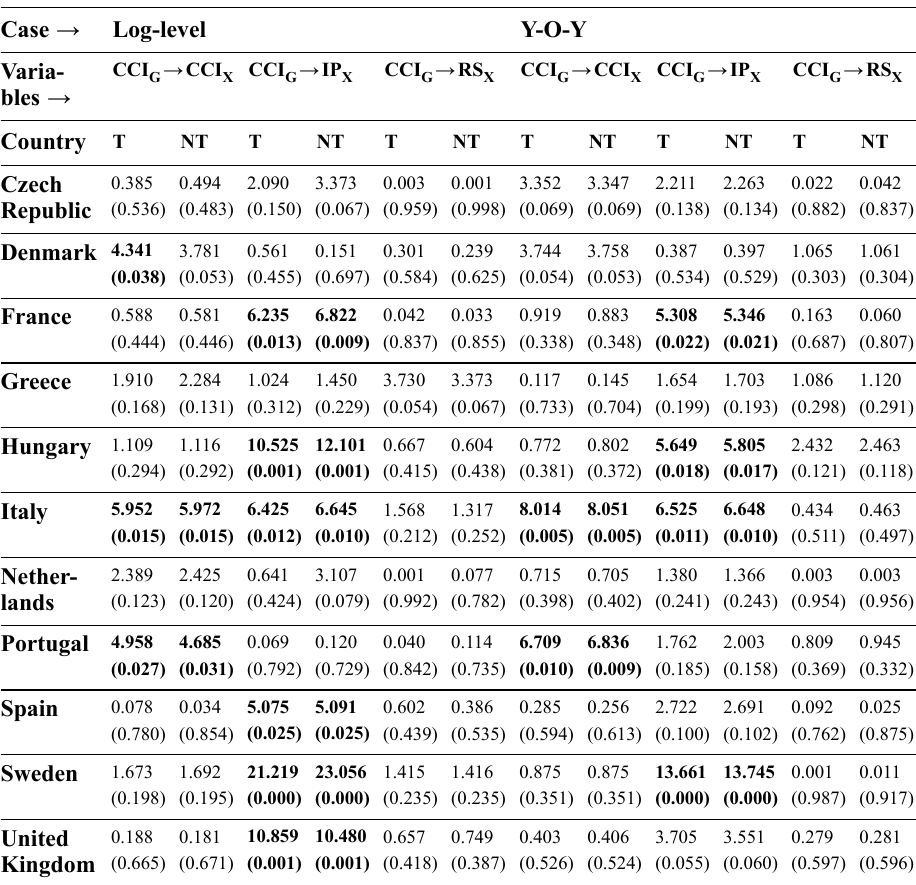
Table 4. Granger causality in time domain for German